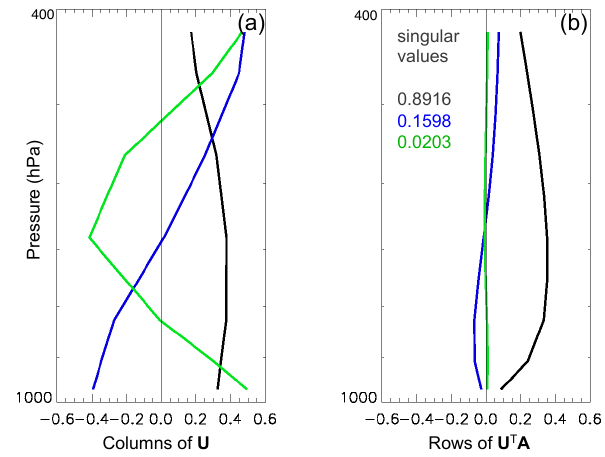
Fig. 4. TES-OMI O 3 AKs for August 2006 CONUS. (a) CONUS average AK from surface to 10hPa, with colors corresponding to pressure levels indicated on the left. (b) CONUS average AK from surface to 421mb. (c) Individual AKs for 906 CONUS observations for the surface (red lines) and 510.9hPa (blue lines) and average surface AK (black line).